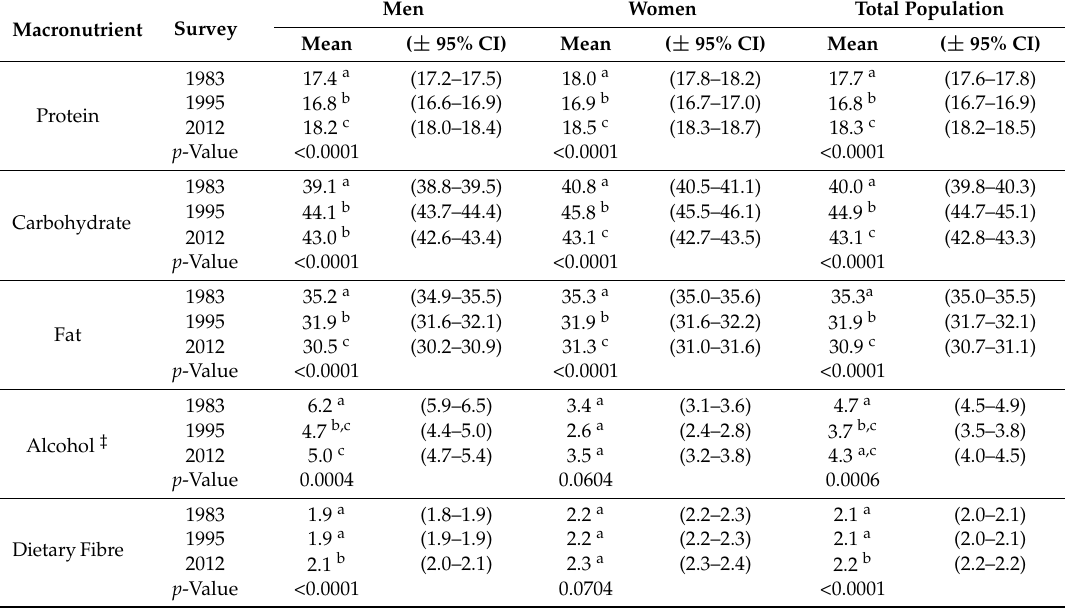
Table 2. Change in percentage energy (%E) of macronutrients for Australian adults aged 25–64 years from National Nutrition Surveys 1983 ( n = 6254), 1995 ( n = 7831) and 2012 ( n = 6552).